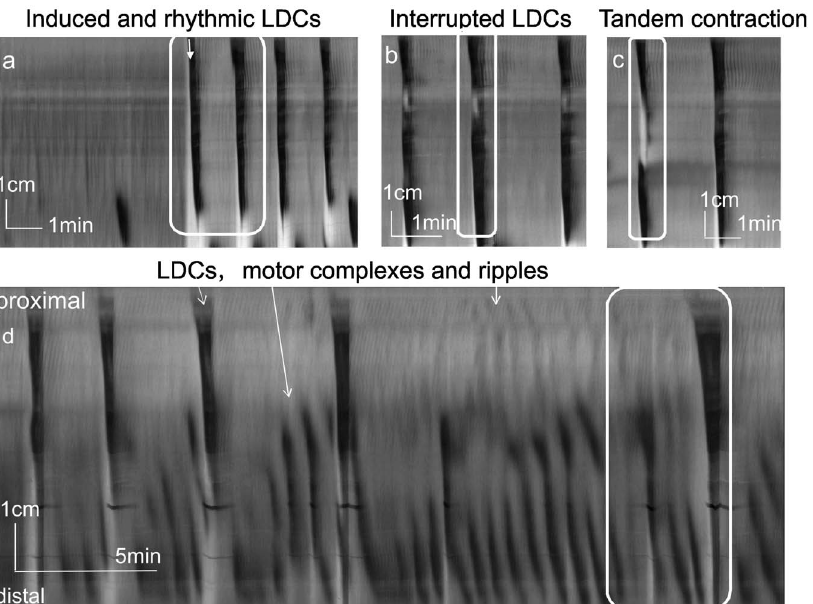
Figure 1. Propulsive motor patterns. Spatiotemporal maps created from video recordings of motor patterns of the whole rat colon. The colon as well as the in and outflow tubes are filled with PBS and the fluid column in the outflow tube determines an intraluminal pressure of 5 cm H 2 O in the experiments described in this figure and all other figures. a. In a quiescent colon, fluid-infusion (at white arrow, see methods) induced a long distance contraction (LDC) which was followed without further stimulus by rhythmic LDCs. Ripples followed the LDCs in the proximal colon. Boxed area=Video S1 ‘‘Induced and spontaneous LDC’’. The white band preceding the first LDC is the distention caused by fluid infusion. The white areas preceding spontaneous LDCs are relaxations preceding the contraction. b. Interrupted LDCs showed a relaxation at about 1/3 down the colon length. The interruption (relaxation) was seen as a white spot on the black contraction. The boxed LDC is shown in Video S2 ‘‘Interrupted LDC’’. c. A tandem contraction (see text) is shown followed by a spontaneous LDC. Boxed area=Video S3 ‘‘Tandem contraction’’ d. Five rhythmic LDCs are shown together with RPMCs. Ripples were seen in the proximal colon. The boxed area is shown in Video S4 ‘‘Motor complexes and LDC’’.